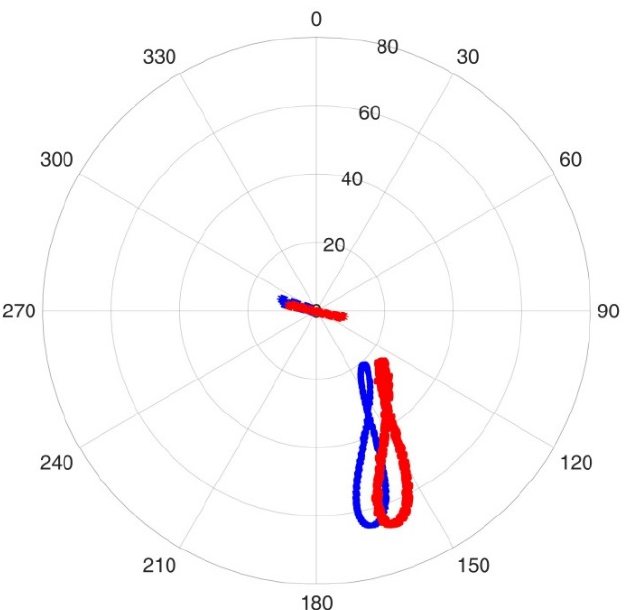
Figure A1. Polar plot illustrating the solar and view geometry of Landsat-8 (red) and Sentinel-2 (blue) data in the study period. The radial straight lines show azimuth spaced every 30° and the circles show zenith spaced every 20°.